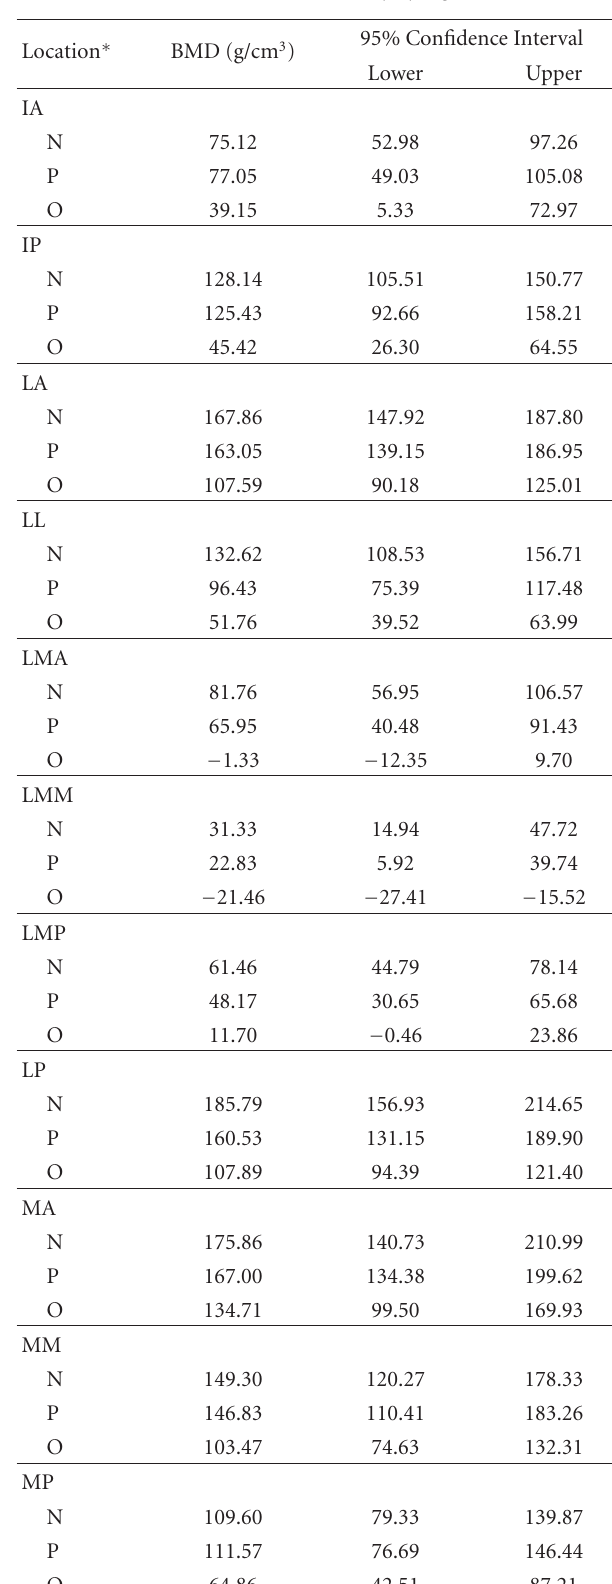
Table 2: Cancellous bone mineral density by region and